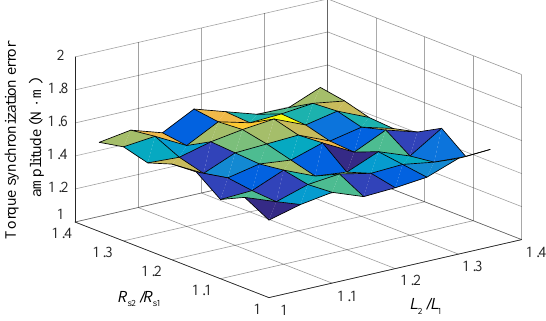
Figure 11. Steady states of synchronous torque control strategies with different inductance and re- sistance.